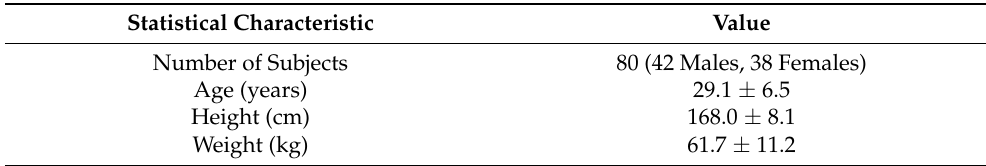
Table 1. Participants’ statistical characteristics.